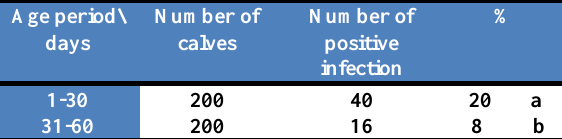
Table, 4: Relationship between age and rotaviral infection in examined calves.